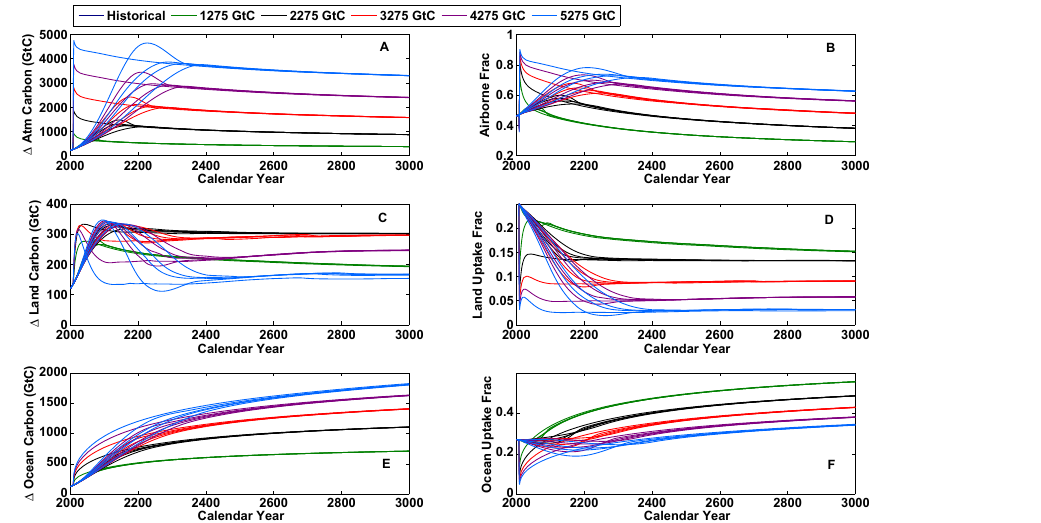
Figure 9. Global carbon cycle response. (a) Atmospheric carbon anomaly (relative to 1800), (b) airborne fraction of cumulative emissions, (c) land carbon anomaly (relative to 1800), (d) fraction of cumulative emissions taken up by the land, (e) ocean carbon anomaly (relative to 1800), and (f) ocean uptake fraction. Note that vertical axes